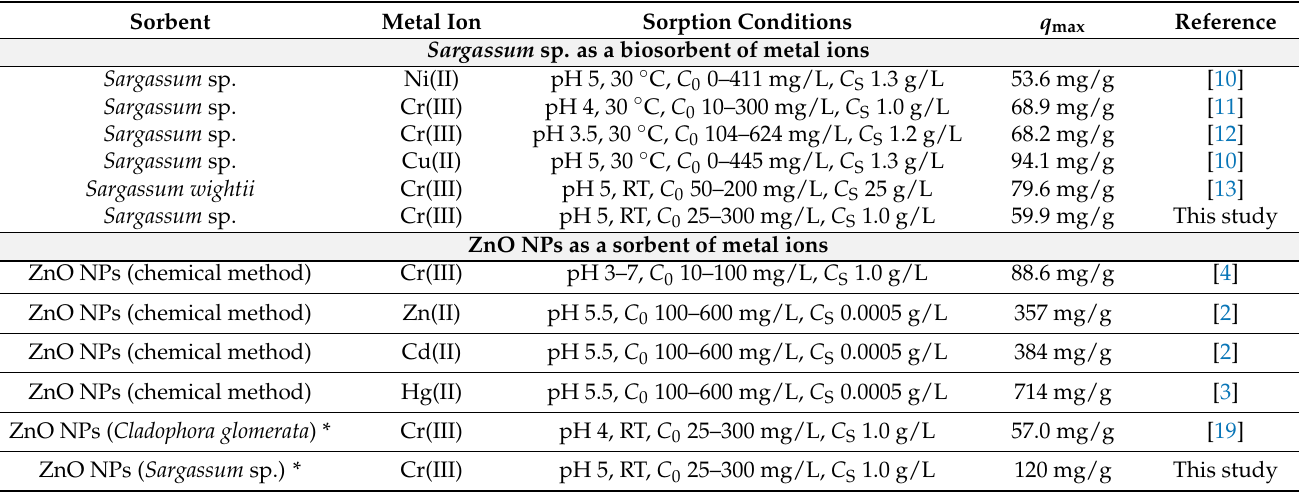
Table 7. Comparison of the values of maximum sorption capacities determined on the basis of equilibrium sorption models depending on the sorption conditions, metal ion, and sorbent